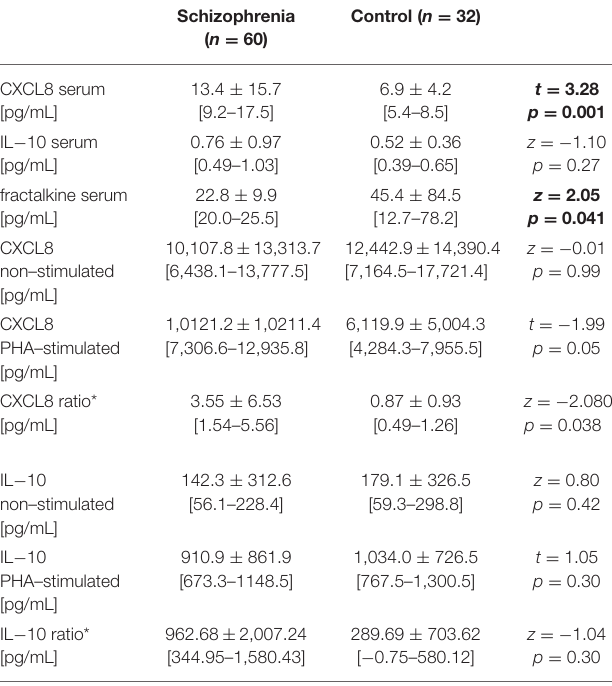
TABLE 4 | Serum and in vitro concentrations of CXCL8, IL − 10, and fractalkine in the study groups. Schizophrenia ( n = 60)